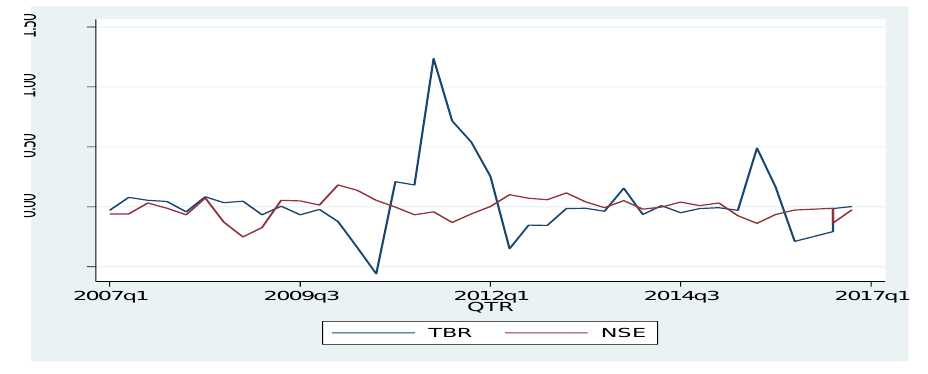
Figure 1 : Trend analysis of 91treasury Bill Rate & NSE 20 Share Index; Source: Study data (2007 – 2016) Trend analysis Inflation & NSE 20 Share Index